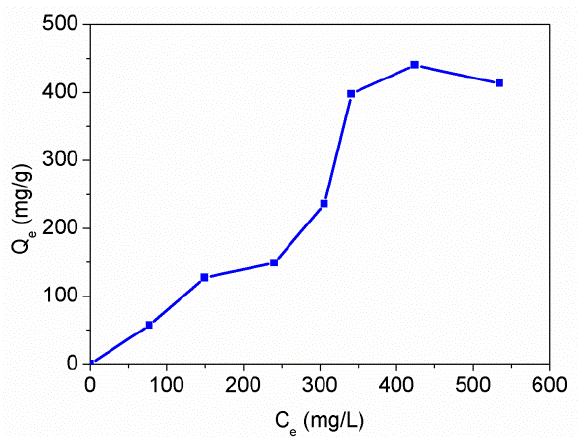
Figure 13. Adsorption isotherm of PAT-PS particles for Hg(II) in aqueous solution (PAT-PS 10 mg, C 0 = 100–600 mg/L, pH 4.5, contact time 24 h).